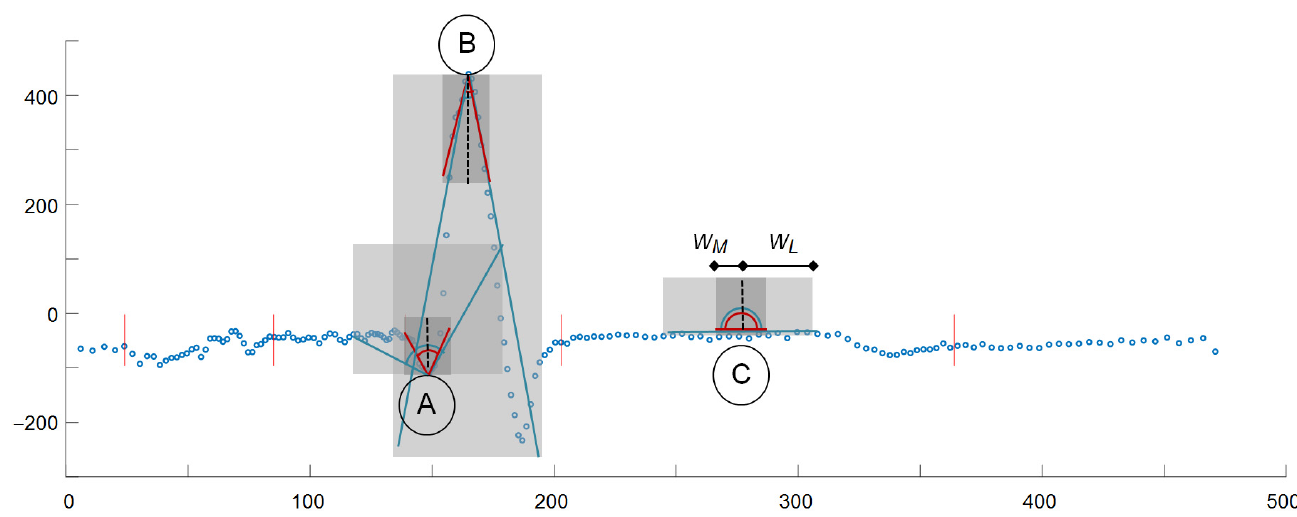
Figure 1. Working principle of the proposed QRS detector for non-uniform ECG signals (File CSE_MA_001, lead aVL). At the beginning of QRS ( A ) M (red) is small but L (blue) is large, at the peak of QRS ( B ) both M and L are small, and at the rising slope of T ( C ) both M and L are large.